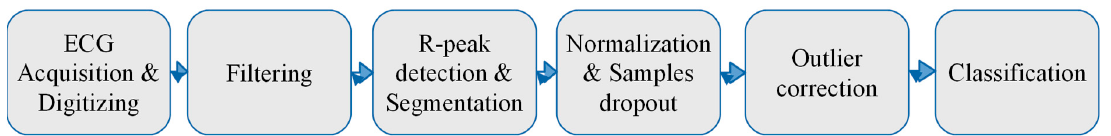
Figure 1. ECG-based identification process.